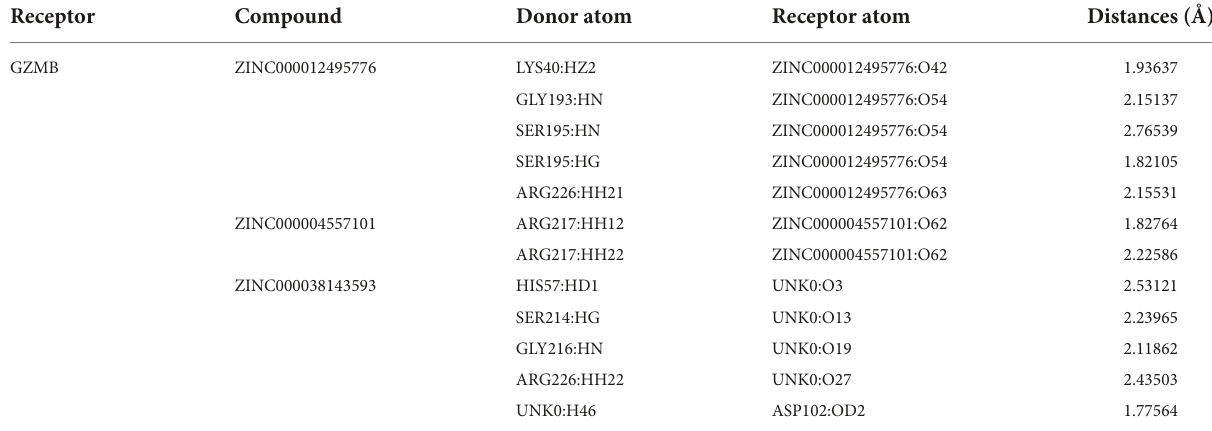
TABLE 6 Hydrogen bond interaction parameters for each compound with granzyme B residues. Receptor